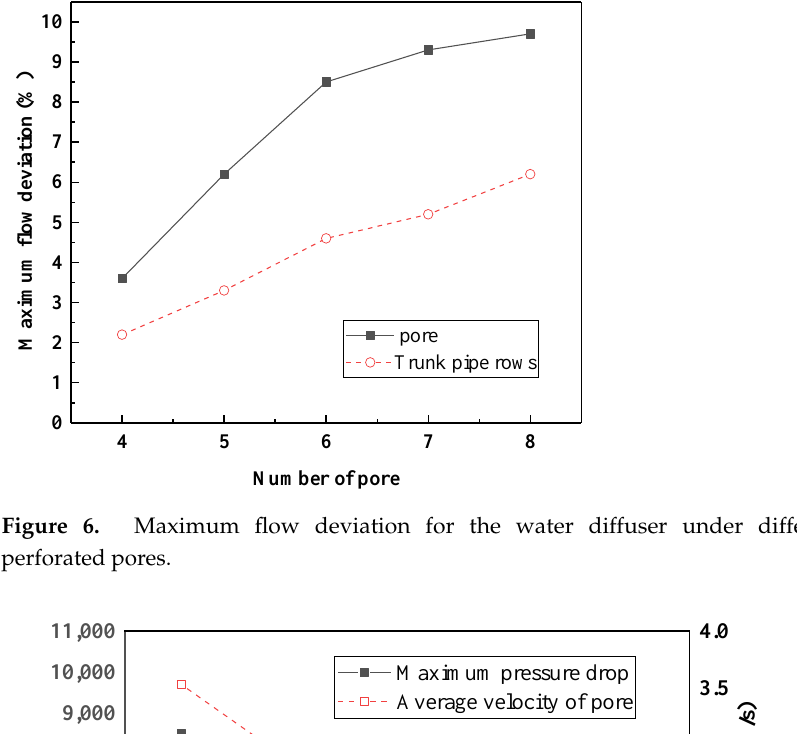
Figure 5. ( a ) Distribution of the velocity at the middle x–y plane of the branch pipe and ( b ) the average velocity and degree of the turbulence for the water diffuser under different numbers of perforated pores.